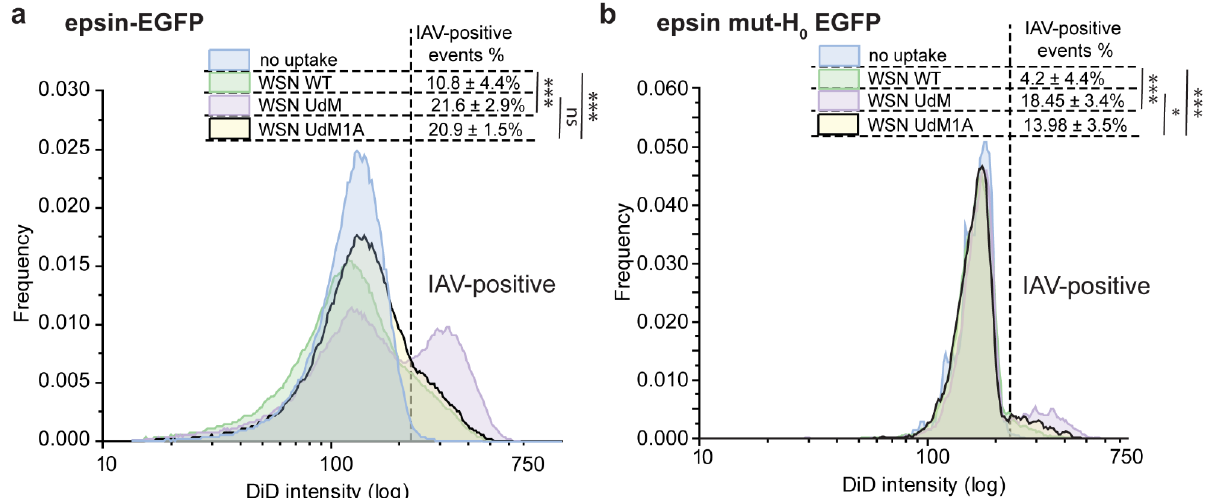
Figure 7. Bulk uptake of WSN-UdM is not affected by mutation H 0 in epsin. ( a ) Uptake (4 h) of WSN-WT, WSN-UdM and WSN-UdM1A by RPE cells stably expressing epsin-EGFP. Percentage of cells with IAV internalization is shown in the inset. ( b ) Uptake (4 h) of WSN-WT, WSN-UdM and WSN-UdM1A by RPE cells stably expressing epsin mut-H 0 EGFP. Percentage of cells with IAV internalization is shown in the inset. For a and b, experiments were repeated n = 3 and standard deviation is provided in the inset. ns represents not significant. *, and *** represent p < 0.05 and p < 0.001 respectively.